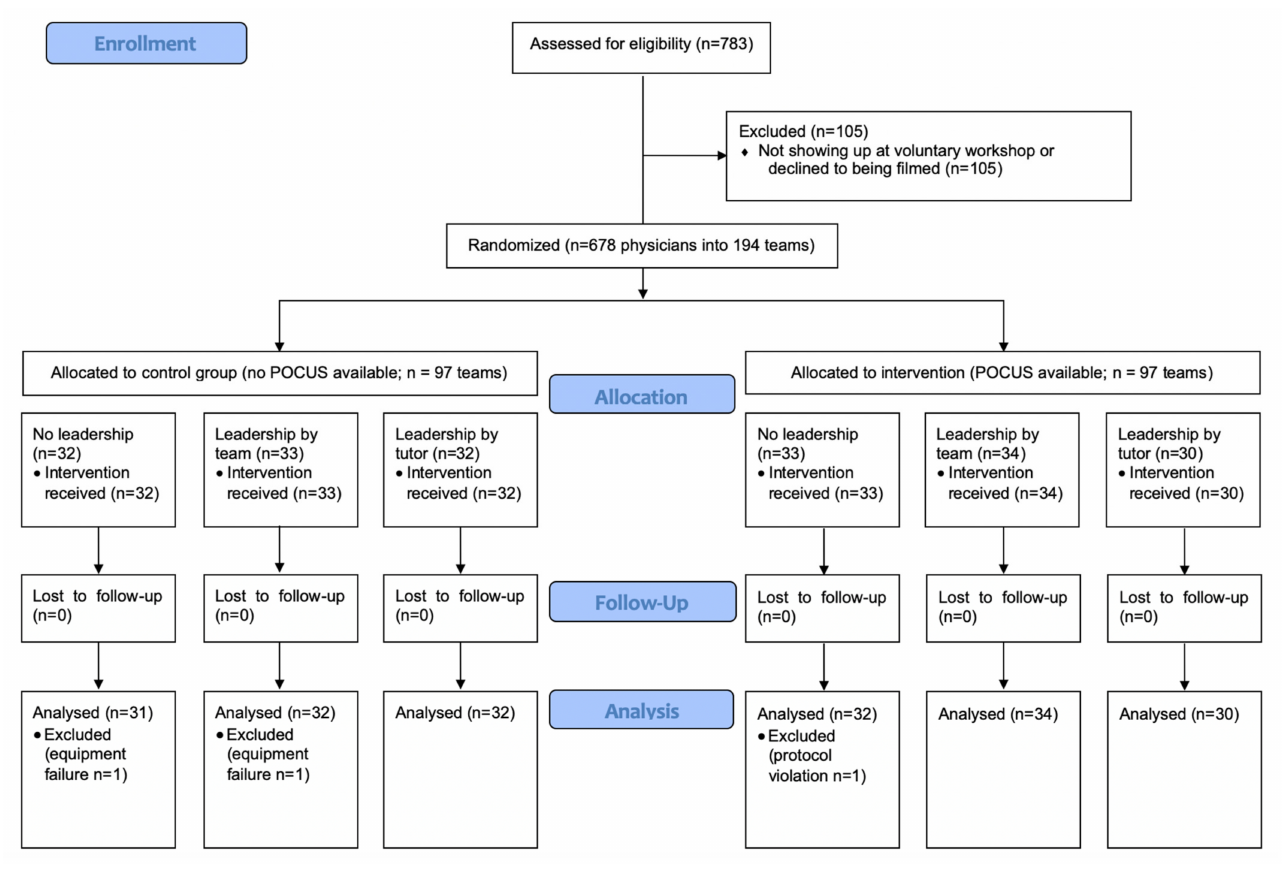
Figure 2. CONSORT flow chart.